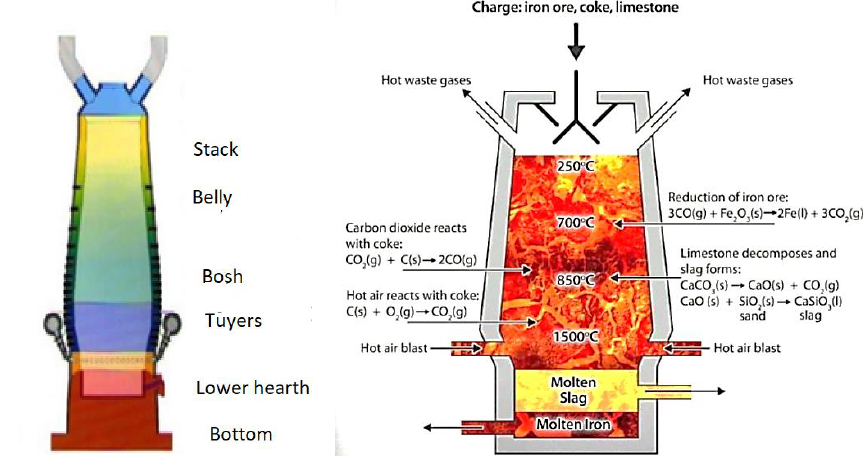
Fig. 4. Regions of the blast furnace with temperature range and chemical reactions [18-21,